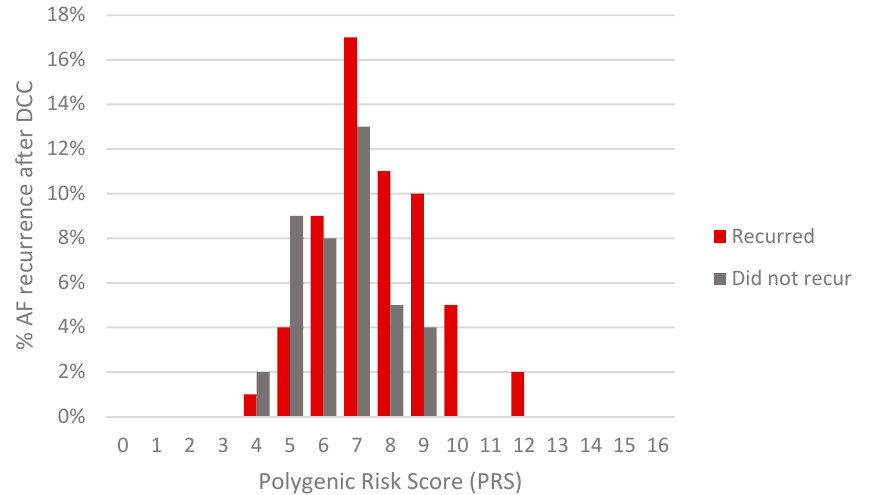
Figure 3. AF recurrence risk based on PRS. The PRS was calculated as the total unweighted number of risk alleles that DCC-treated patients with and without AF recurrence had ( n = 58 patients and n = 39 patients, respectively).